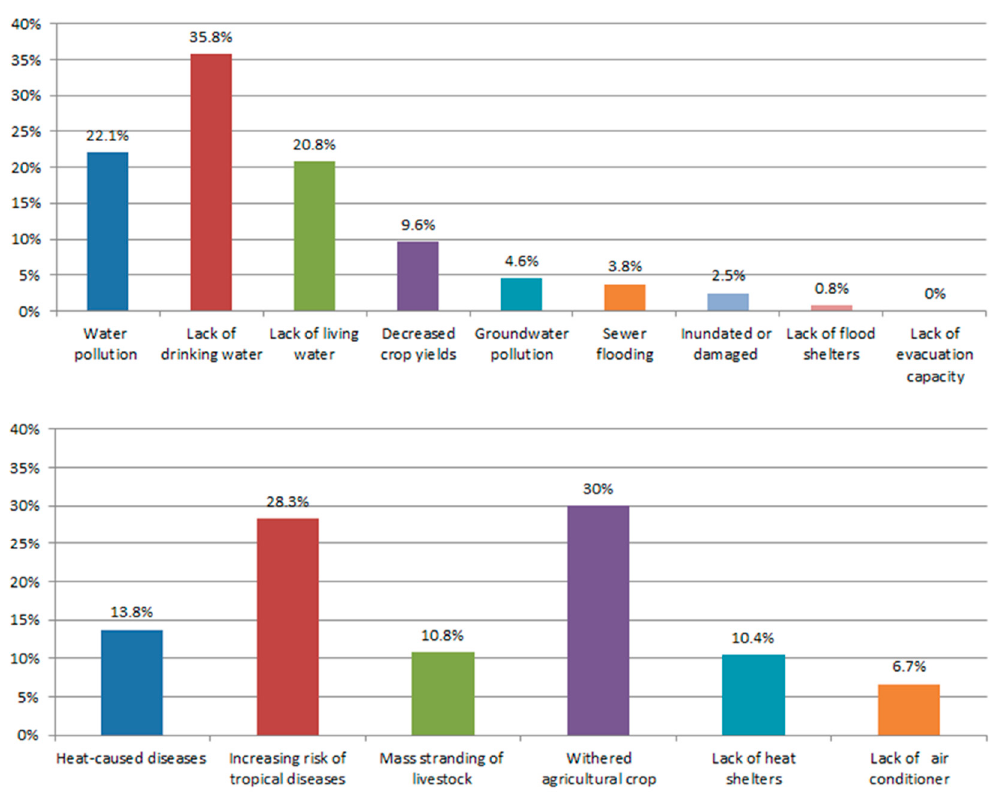
Figure 8. Most important climate change risks with respect to water ( top ) and heat ( bottom ) sectors as assessed by the women respondents.